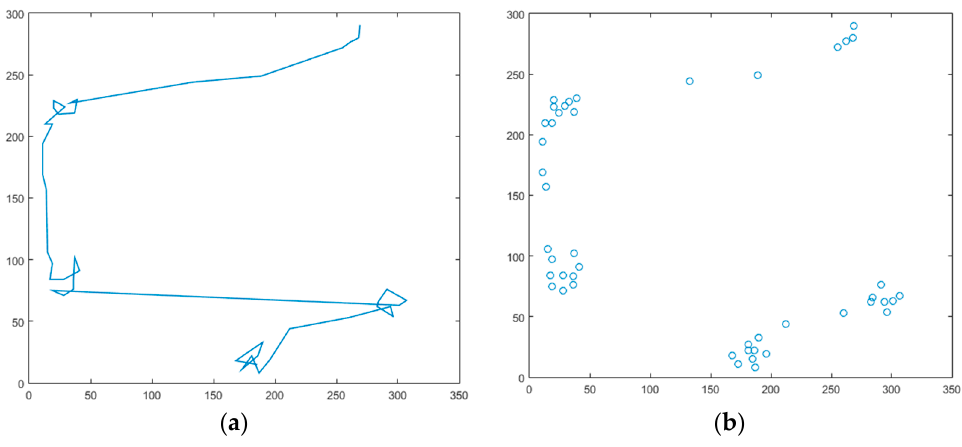
Figure 17. Eye gaze coordination for 2. Scenario (Figure 12) (2D line graph ( a ), scattered ( b )). The robot wheel speed for the two scenarios is shown in Figure 18. And, the Robot trajectory from the experiment of Figure 14 is shown in Figure 19.